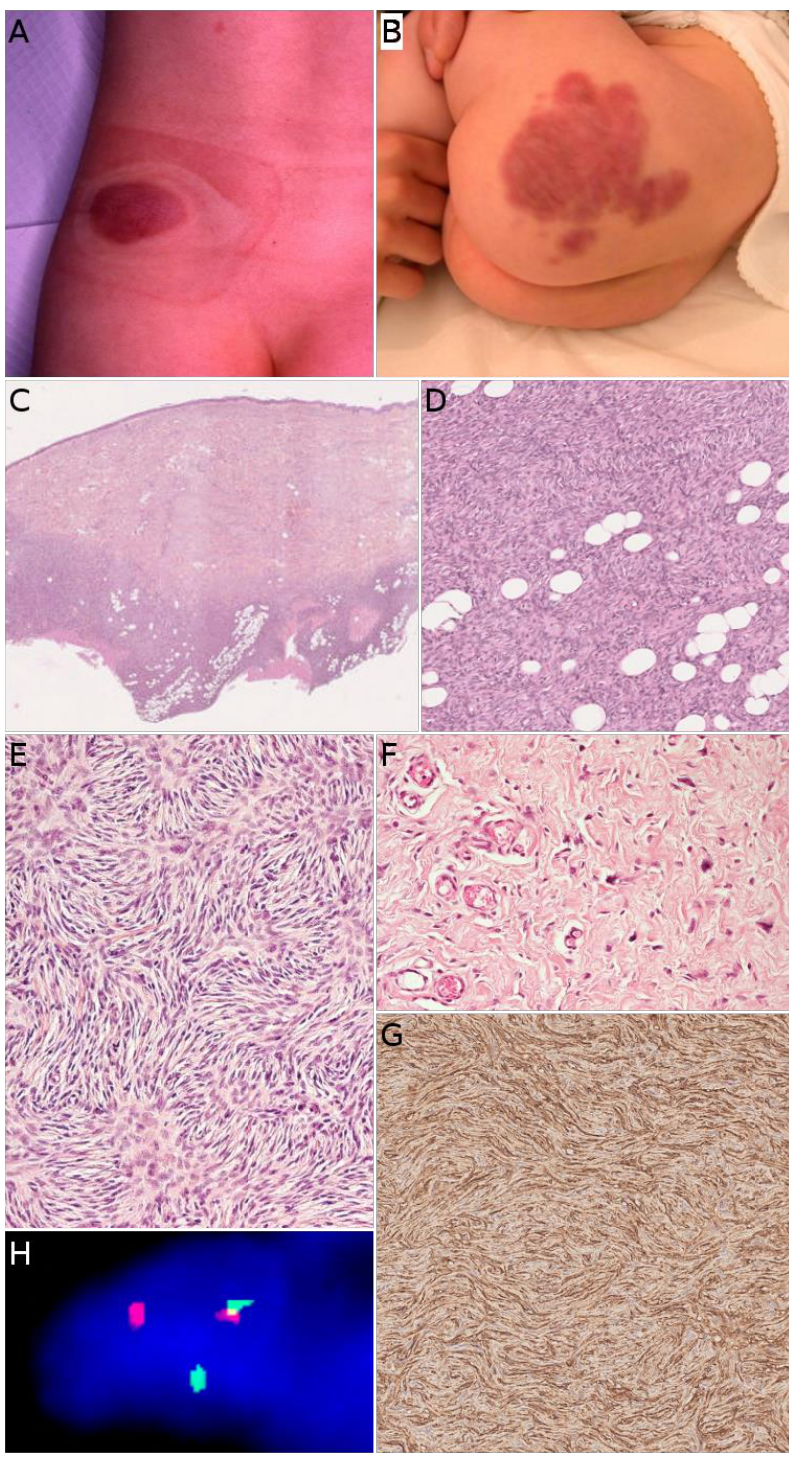
Figure 5. Dermatofibrosarcoma protuberans: ( A ) Plaque-like lesion on the flank of a teenager; ( B ) irregular plaque-like lesion on the buttock of neonate (congenital lesion); ( C ) dense cellular proliferation infiltrating into the subcutaneous fat (×25); ( D ) infiltration of the subcutaneous adipose tissue (×100); ( E ) spindle cells in a typical storiform pattern (×200); ( F ) giant cell fibroblastoma: less cellular tumor with giant cells and a loose stroma (×100); ( G ) diffuse strong CD34 positivity (×100); ( H ) COL1A1-PDGFB fusion on FISH.